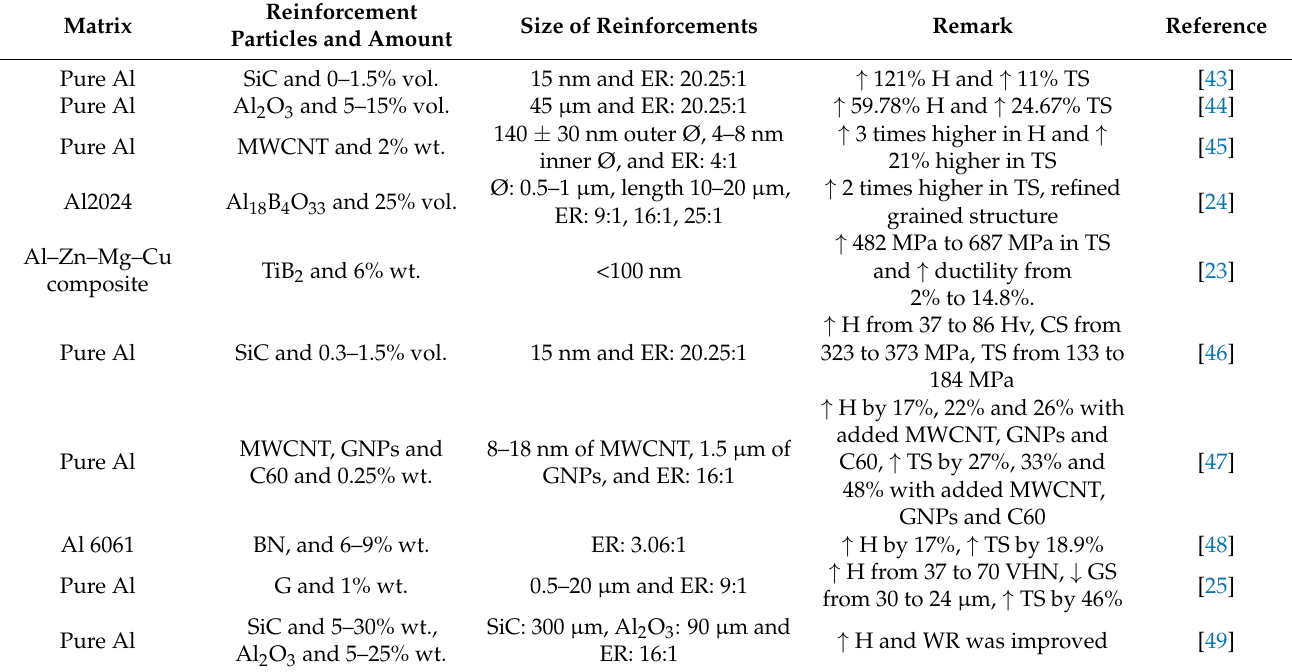
Table 1. Summary of literature review of extrusion of aluminium alloys and their